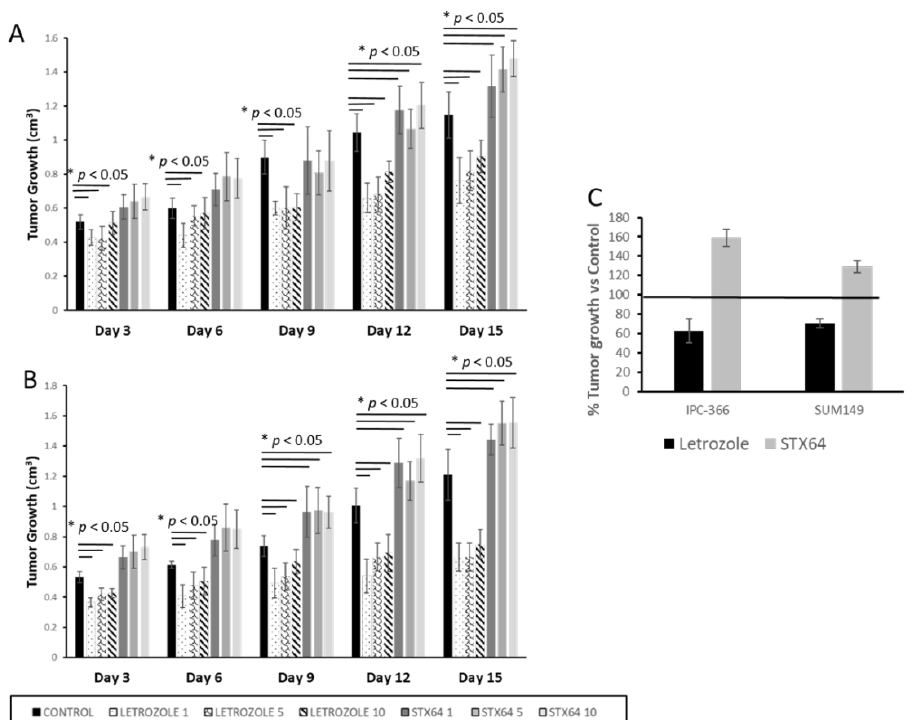
Figure 3. Percentage of tumor growth in SCID mice inoculated with ( A ) IPC-366 and ( B ) SUM149 cells. Animals were treated with 1, 5 and 10 mg of letrozole or STX-64 during 15 days. Bar represents average percentage ± SD. * denoted significant differences between control and treatments. ( C ) Global representation of the effect of letrozole and STX-64 treatment on IPC-366 and SUM149 tumors. Bars denoted the mean percentage of tumor growth of all letrozole and STX64 treated mice versus control group at the end of the experiment. Black line represents control group as 100%. Letrozole treatment reduced approximately 30% of tumor growth, while STX-64 augmented tumor volume around 20%.